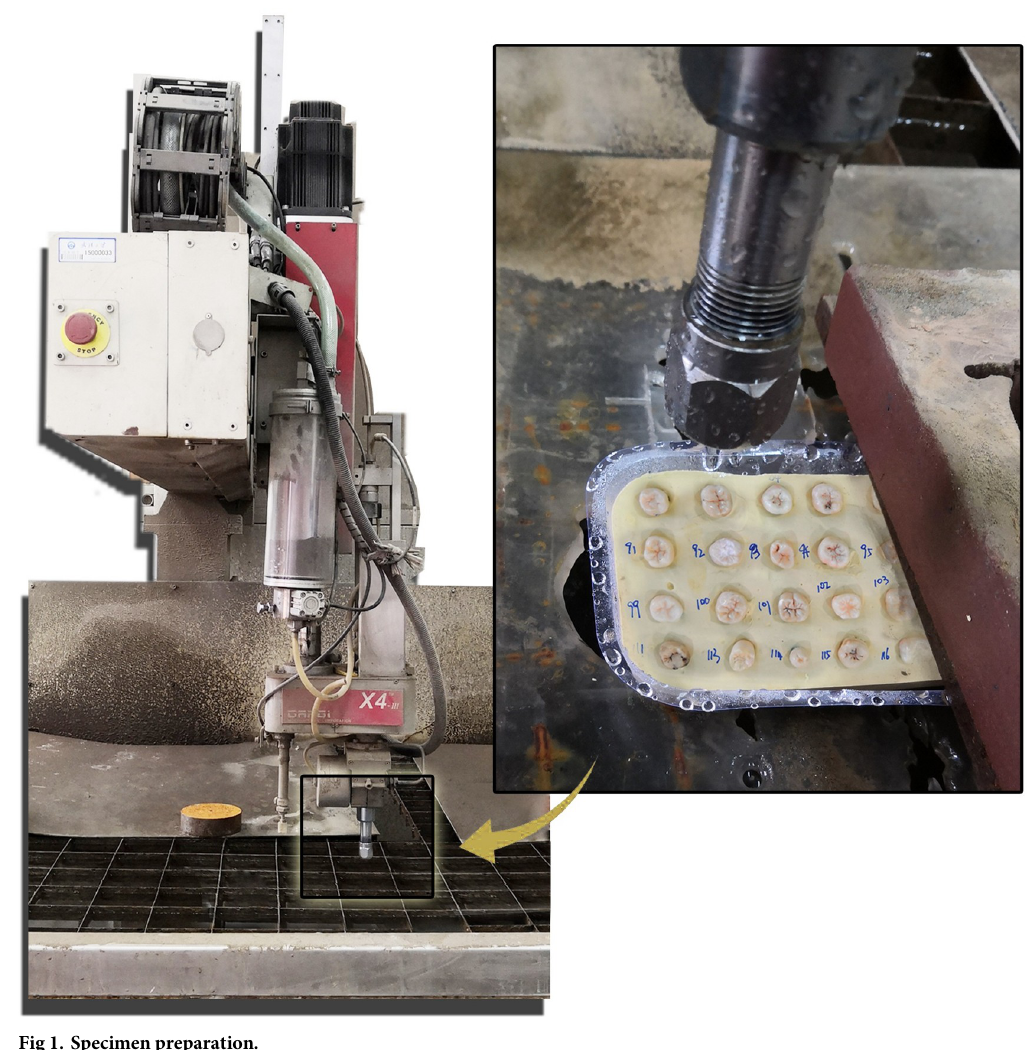
Fig 1. Specimen preparation.